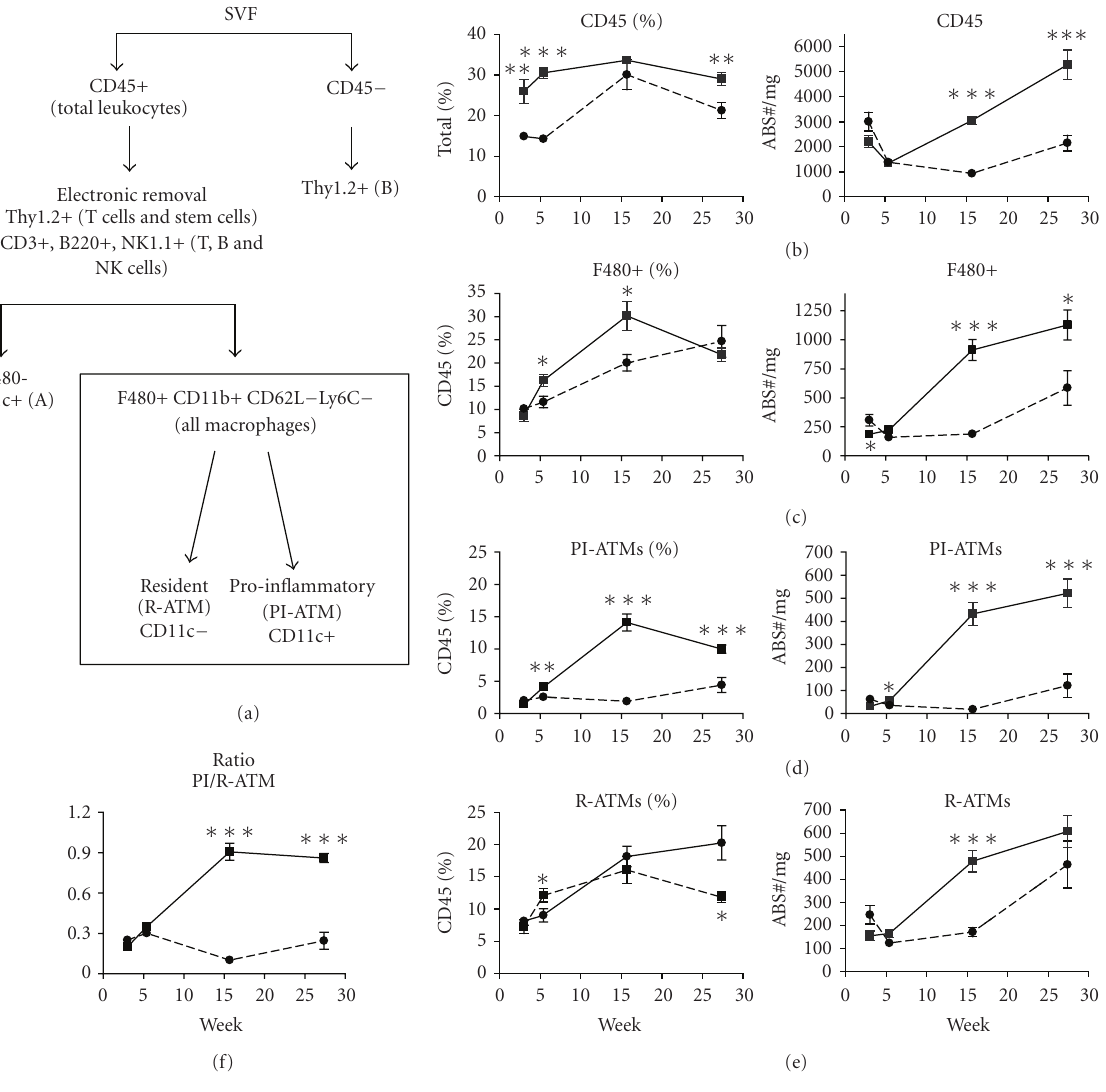
Figure 2: Progressive infiltration of pro-inflammatory ATMs assessed by flow cytometry. The epididymal fat pads were isolated from n ≥ 7 animals per group at each time point. The SVF was isolated and stained to identify total leukocytes (b), macrophages (c), the pro-inflammatory (d) and resident (e) ATM subsets according to the gating strategy (a). The ratio of the pro-inflammatory ATMs over the resident ATMs is a quick indicator of the phenotypic profile of the SVF macrophages. Values represent the mean and SEM. The Chow group is represented by circles and dashed lines and the DIO group on HF/CH diet is represented by squares and a solid line. Unpaired T test was used to compare standard chow to DIO at each time point; ∗ P ≤ . 05, ∗∗ P ≤ . 01, and ∗∗∗ P ≤ .